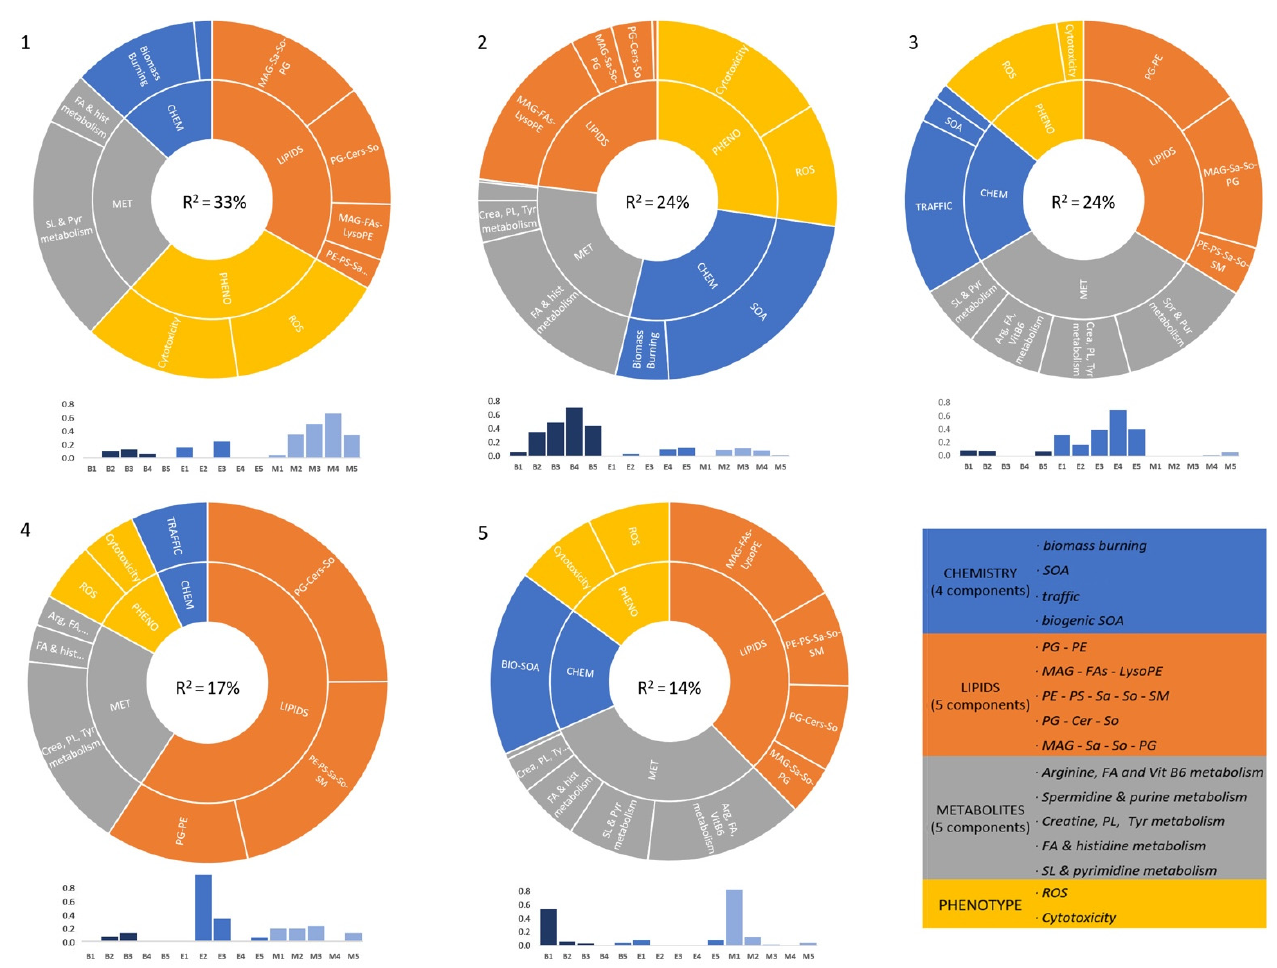
Figure 5. MCR-ALS resolved components of the chemical and biological effects fused data. Graphical representation of each of the MCR-ALS components. Solar plots indicate the contribution of each of the four data blocks on that component. Bar plots indicate the distribution of the component within the samples investigated. Different colors are meant to facilitate the visualization of samples of each air quality station. For more clarity, the composition and the short names of the components previously resolved in each data block are shown on the right-bottom.